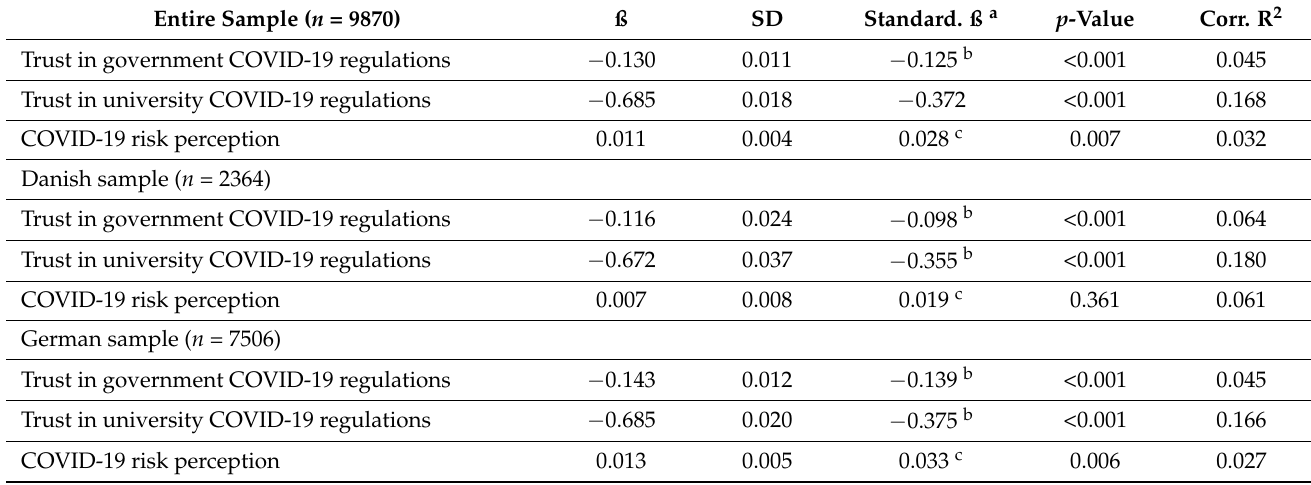
Table 3. Associations between COVID-19-related academic frustration (dependent variable) and